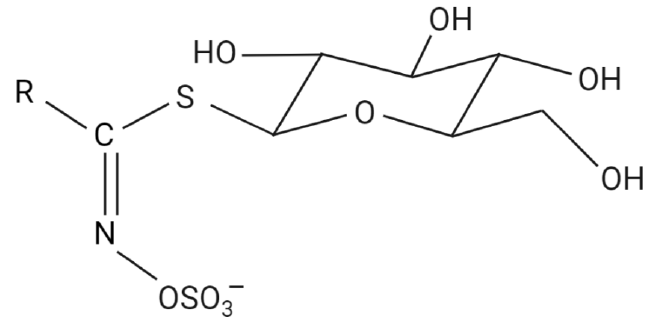
Figure 1. Basic chemical structure of glucosinolates. The basic structure of glucosinolates comprises a thioglucose residue and a sulfate group bound to a central carbon, along with a variable aglycone. Figure created with BioRender.com (accessed on 20 October 2021).